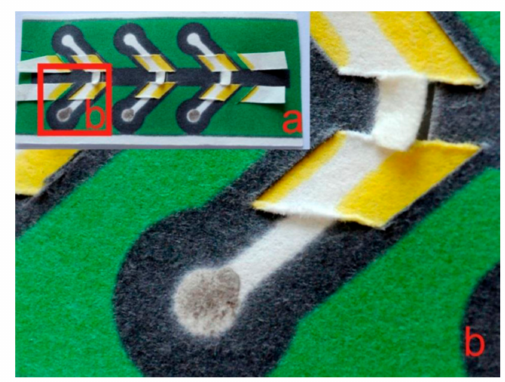
Figure 14. ( a ) The photograph of the switch-on-chip and ( b ) the enlarged view of the inlet and the pretreatment zone